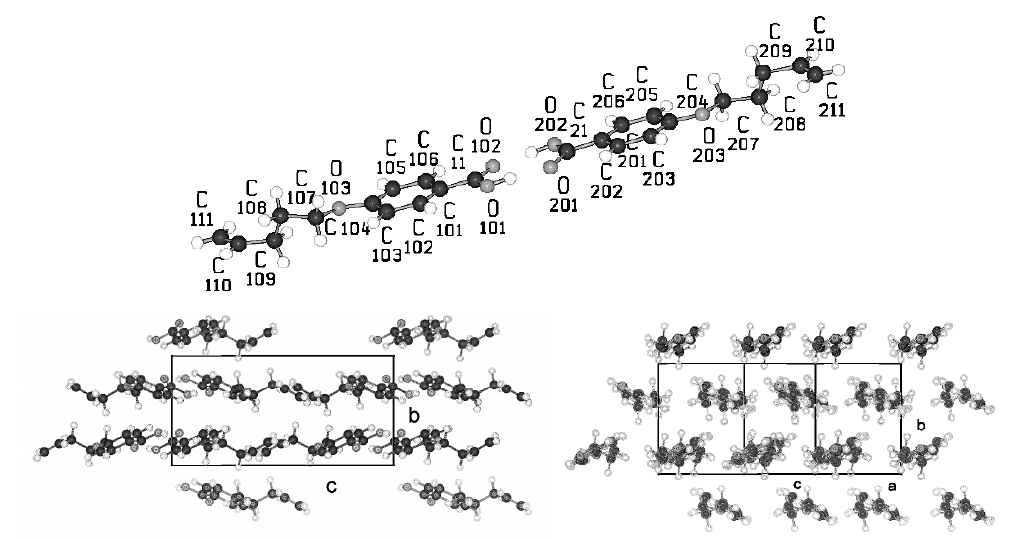
Figure 15. Representation of the conformation of two independent molecules forming dimers and the packing arrangement in space group P2 (POBA) in two projections along [100] and along the molecular axes.